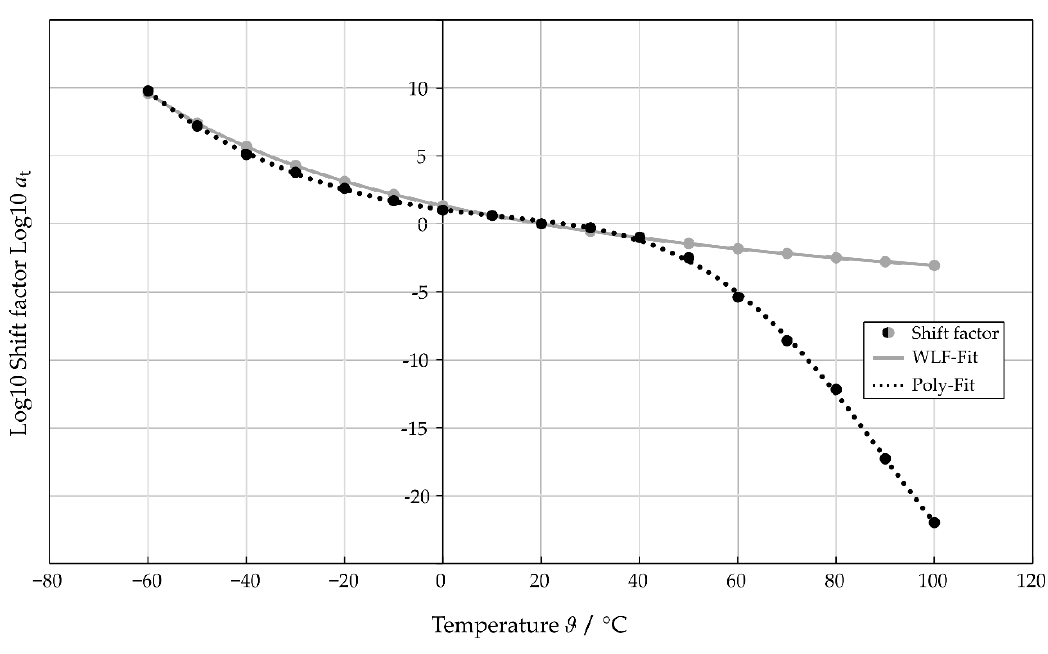
Figure 5. Calculated shift factor as a function of temperature based on the WLF method and an eighth-degree polynomial approximation.